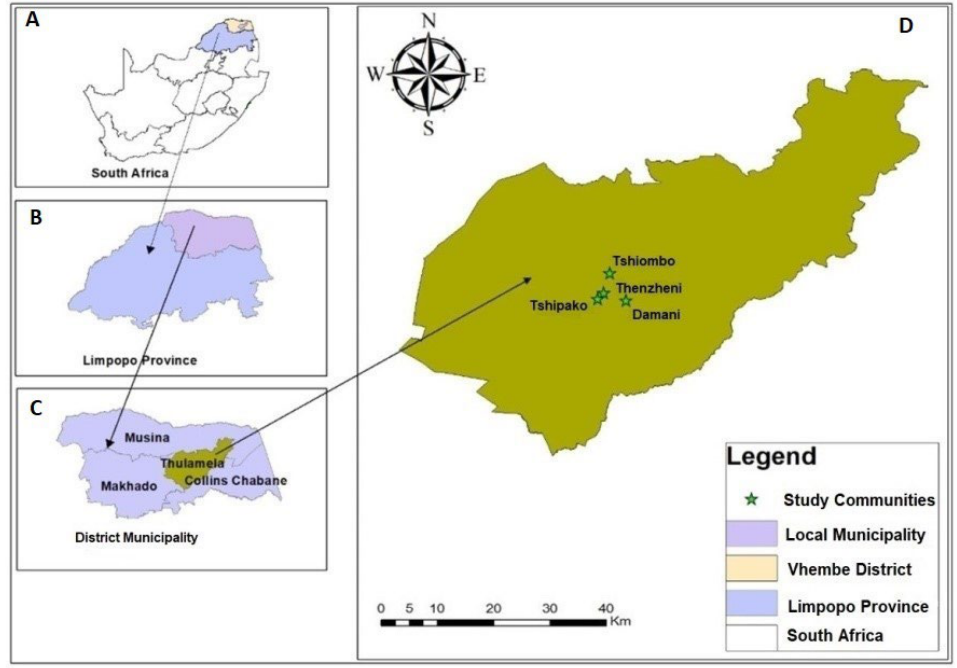
Figure 1. Map showing the study areas and location within ( A ) national, ( B ) provincial, ( C ) district and ( D ) community contexts.